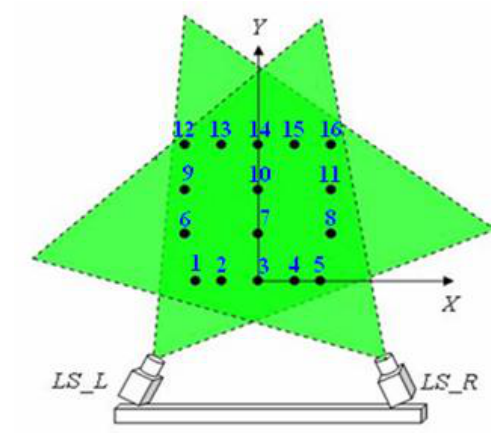
Figure 5. Diagram that show the viewing planes crossed by calibration pattern